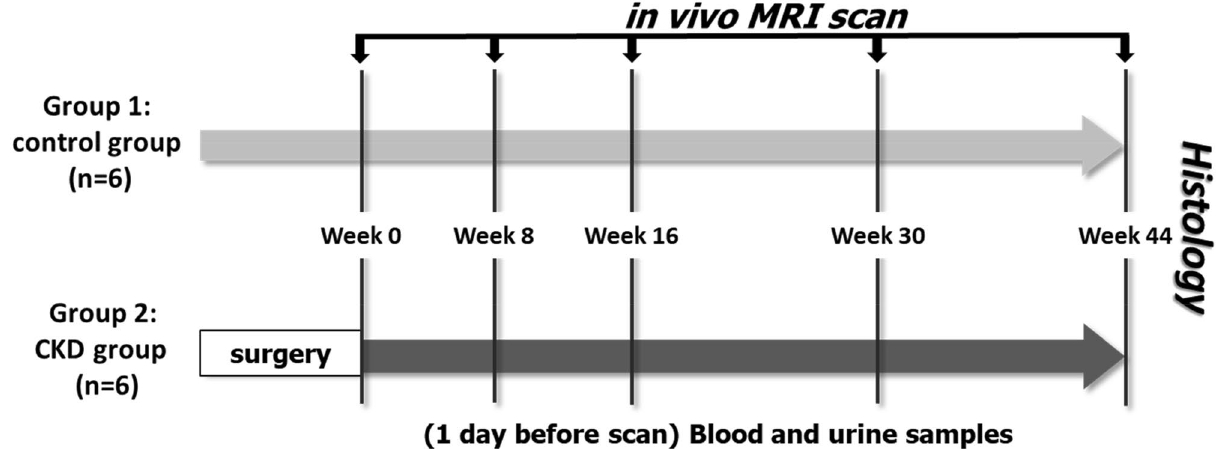
Figure 5. Flow chart of the experimental design. In vivo MRI scan (including DCE-MRI and MRI-T2*) was performed in Groups 1 and 2 at week 0, 8, 16, 30, and 44 after surgery in Group 2, indicated by arrows. At week 44, all rats were sacrificed and underwent histological